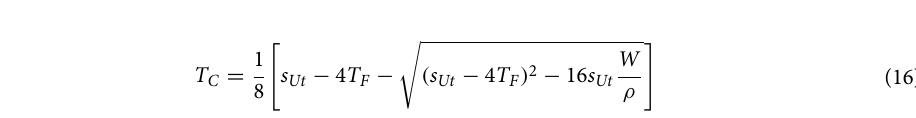
Figure 10. Changes in total pressure drop and dust removal efficiency with W during plane filtration ( a ) change in total pressure drop with W , ( b ) changes in dust concentration and dust removal efficiency with W after